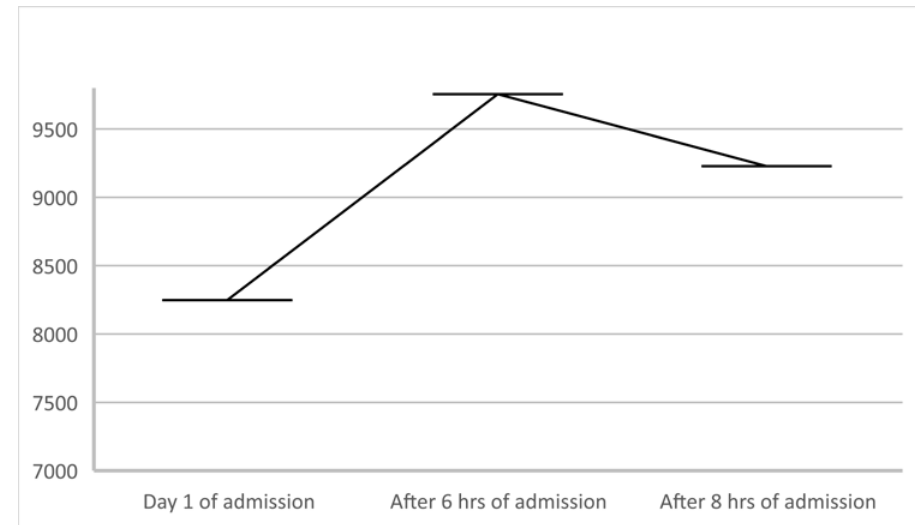
Figure 3. hsTnI (high sensitive I troponin) behavior during hospitalization.